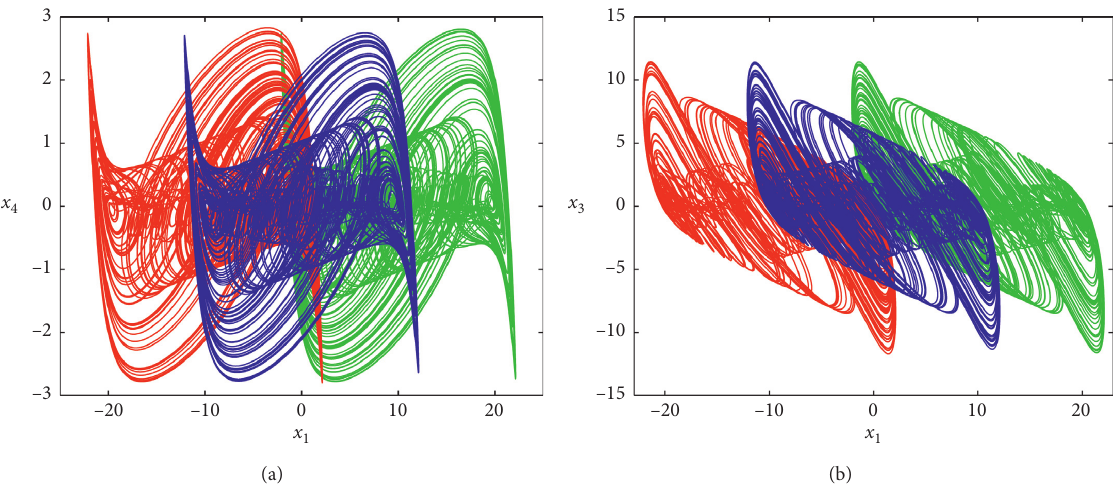
Figure 19: Offset boosting of the double-band chaotic attractor with the following values of parameter: k � 0(blue), k � 10(red), and k � − 10(green). The other parameters are the same as those in Figure 4. 1111.51212.513 x 1